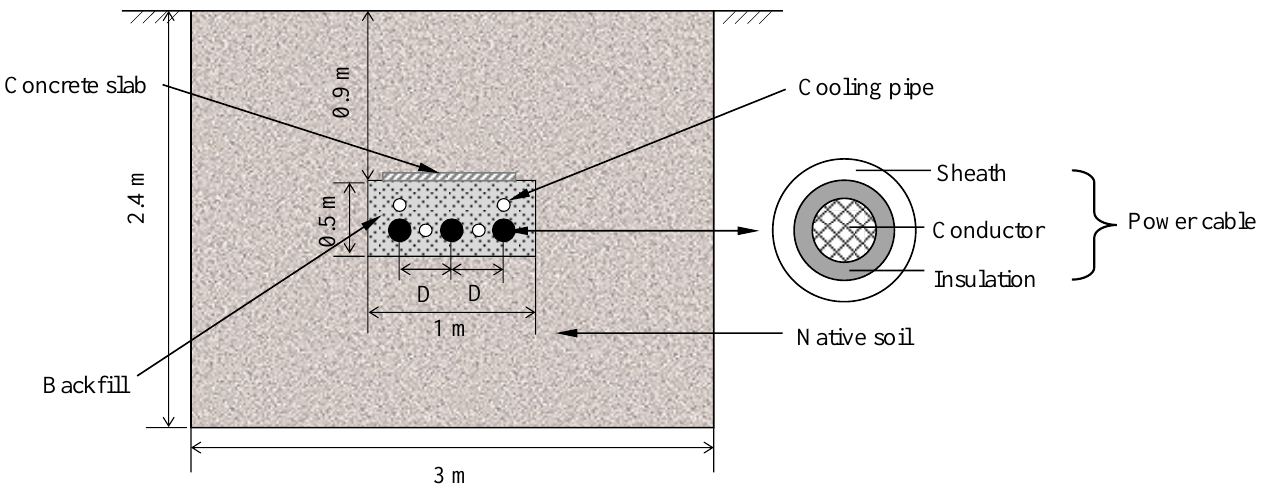
Figure 2. Cable working domain, adopted from Central Electricity Generating Board [31].